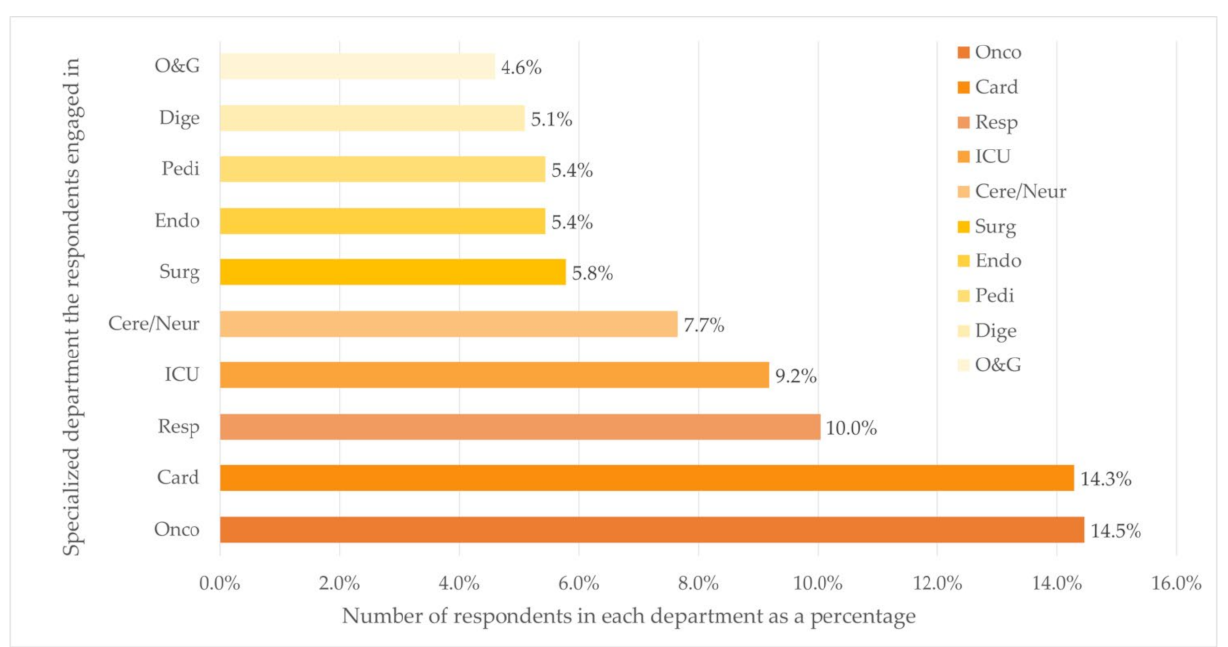
Figure 1. Distribution of department (Top ten) ( n = 588). Department: Oncology (Onco), Cardiovascu- lar (Card), Respiratory (Resp), Cerebrovascular/Neurology (Cere/Neur), Surgery (Surg), Endocrine (Endo), Pediatrics (Pedi), Digestion (Dige), Obstetrics and Gynecology (O&G). Of the 588 respondents, 27.0% ( n = 159) were male and more than half aged less